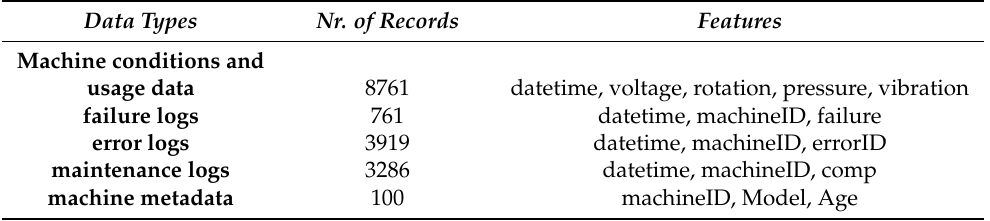
Figure 2. This Figure shows the relation of this research to the previous research work, which considers intrinsic (self-dependency) interdependencies. Furthermore, it highlights the focus of this research work which in addition to intrinsic dependency, demonstrates also the impact of interdependencies between components (i.e., MCS interdependencies). Table 2. This table describes the considered dataset to conduct the experiments within this research work. For more details concerning data engineering/selection process, please refer to previous research work